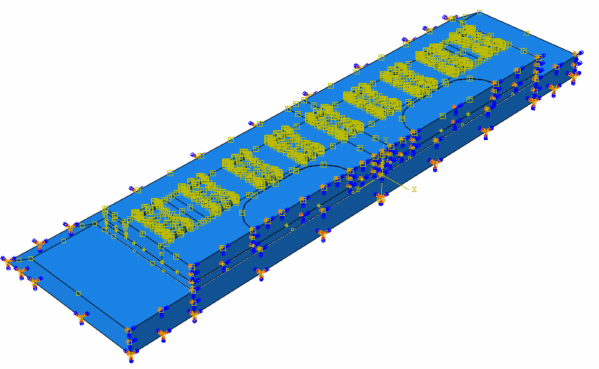
Figure 11. Finite element model of 1/2 NFTBT under temperature gradient